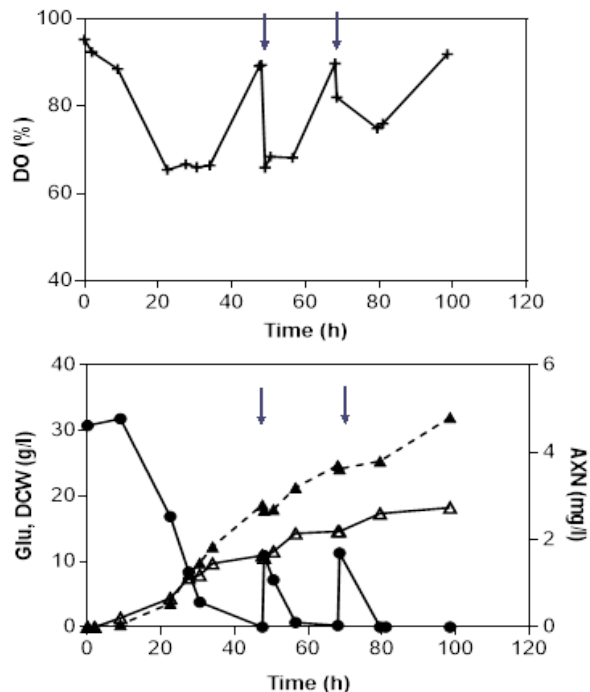
Figure 3. Fed-batch cultivation of X. dendrorhous in a 2-L stirred tank bioreactor. Fermentation conditions: aeration, 1 L/min; temperature, 20 °C; pH 6. Symbols represent: ( ▲ ) astaxanthin, AXN (mg / L); ( • ) glucose, Glu (g / L); ( ∆ ) dry cell weight, DCW (g / L); ( ) ethanol, EtOH (g / L); ( + ) dissolved (cid:35) oxygen, DO (%). Arrows indicate feeding